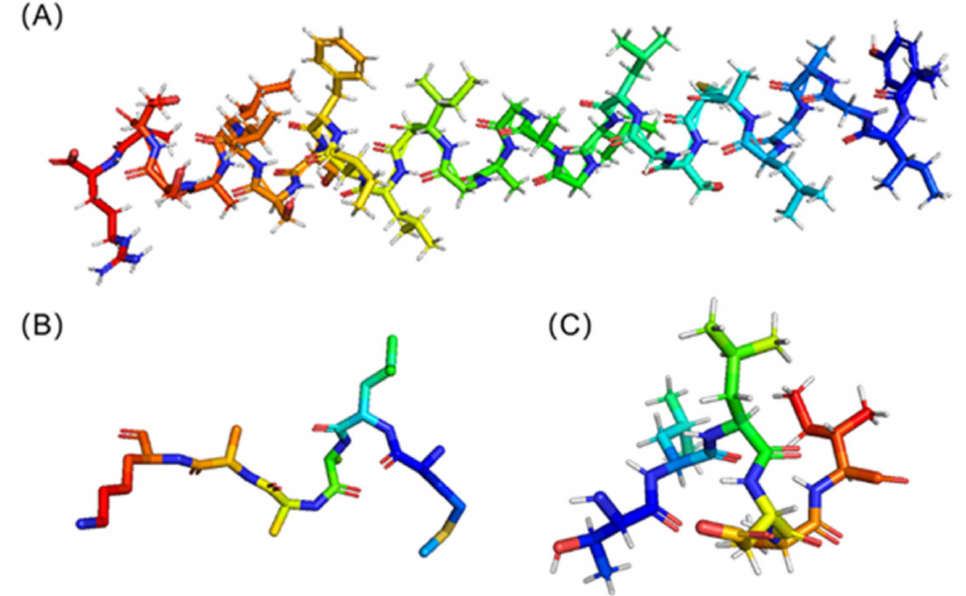
Figure 3. ( A ) The 3D Structure of Protein No. 2; ( B ) The 3D Structure of Protein No. 1; ( C ) The 3D Structure of Protein No.